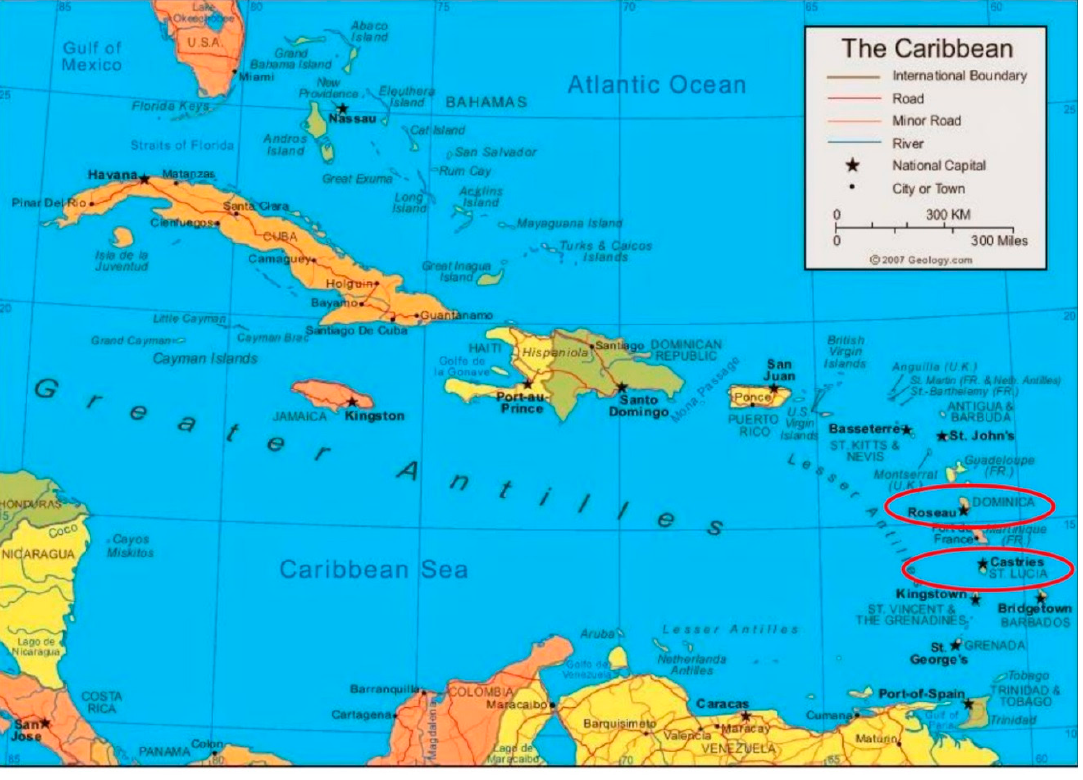
Figure 1. Map of the Insular Caribbean with the two case-study countries of Dominica and St. Lucia identified.